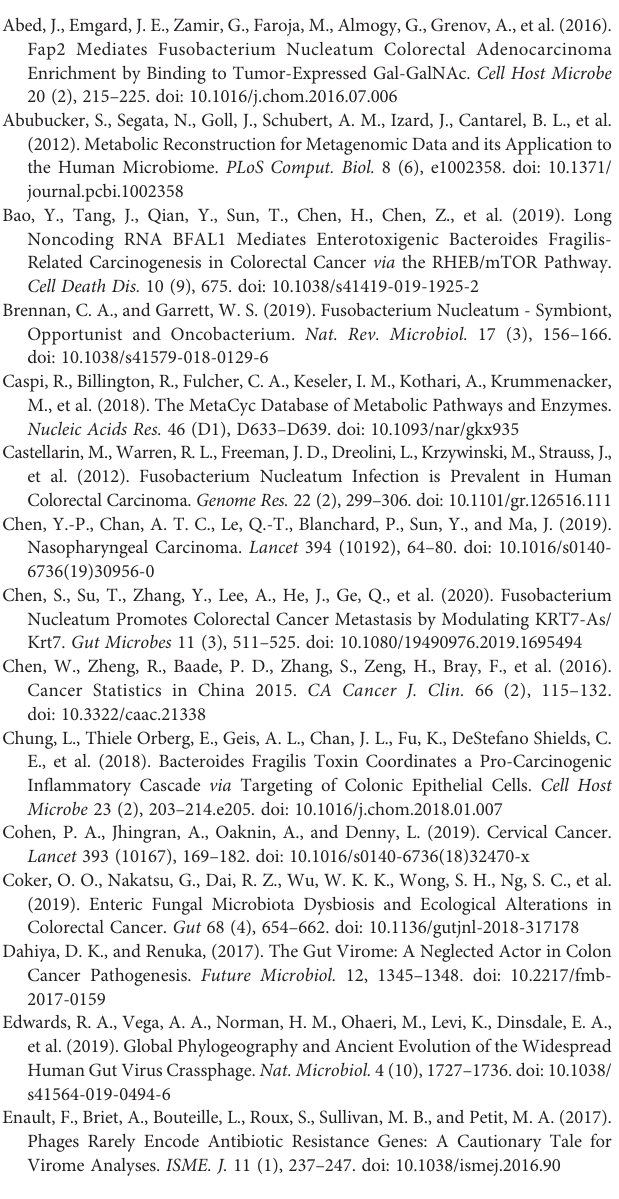
Supplementary Figure 4 | The correlations of the gut bacteria (A) and viruses (B) in healthy control, adenoma, and colorectal cancer. Supplementary Figure 5 | The indexes and function alteration in adenoma and colorectal cancer. The betweenness (A) , closeness (B) , and degrees (C) of the gut microbiome among the control (colored in green), adenoma (colored in amber), and CRC (colored in dubonnet) groups. Principal coordinate analysis of the functions change of gut microbiome at KO level (D) between adenoma and healthy control and that at pathway level between CRC and control (E) . **P<0.01 ***P<0.001 Supplementary Figure 6 | The relationships of bacteria and viruses in all the samples. *P <0.05 + P <0.01.